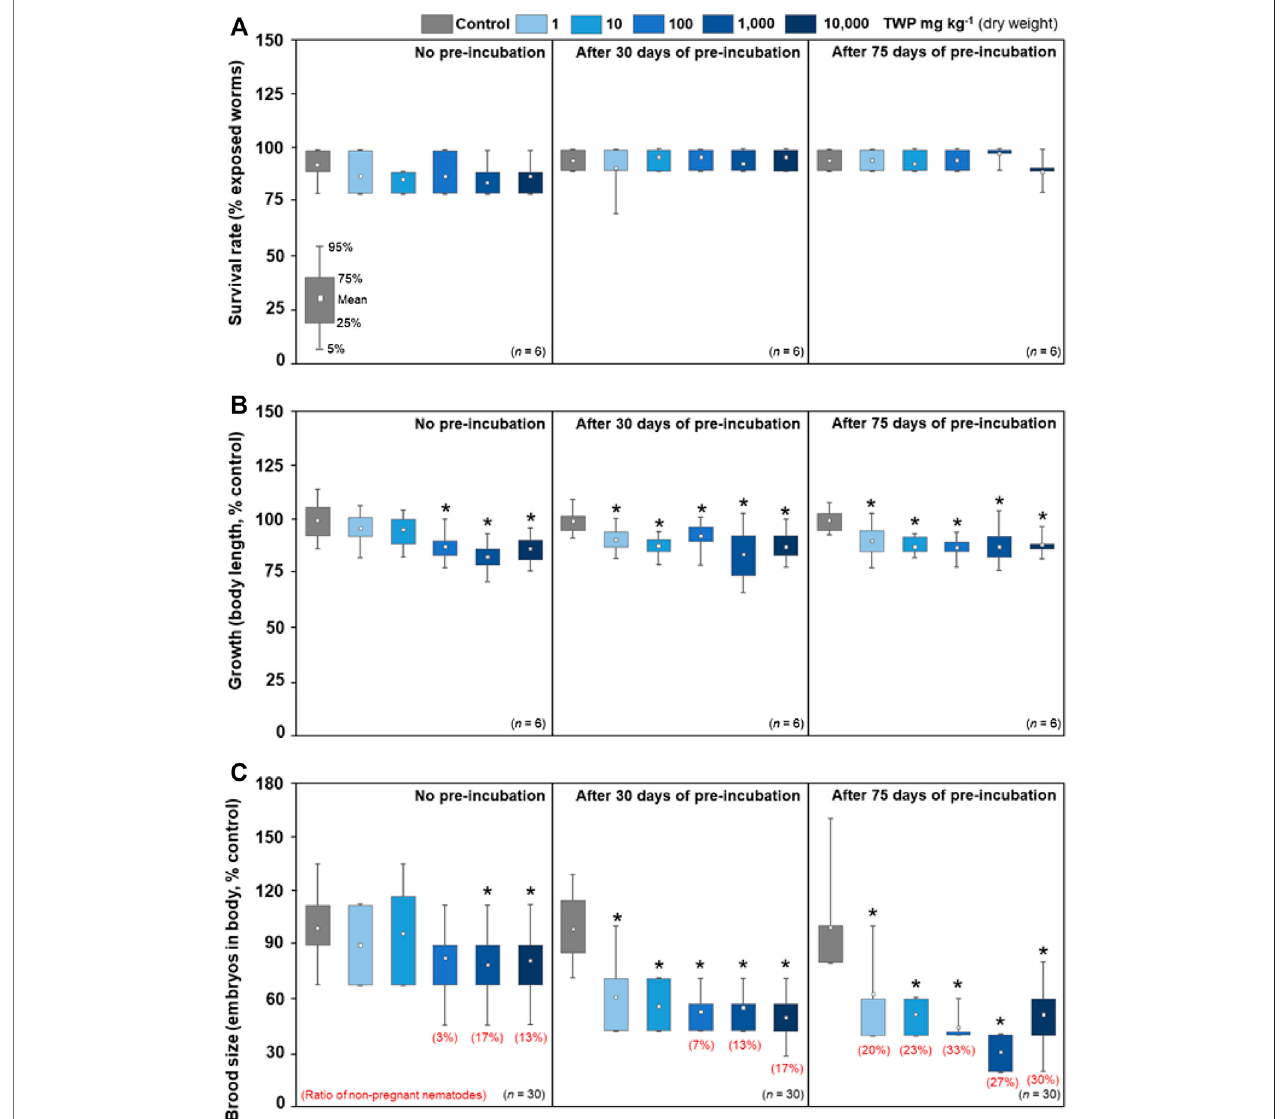
FIGURE 2 | Toxic effects of TWPs on (A) survival, (B) growth (body of length), and (C) brood size (number of embryos in body) of C. elegans after short-term exposure period (2 days). The short-term exposure tests were performed after three different soil pre-incubation times (no pre-incubation, 30 days, and 75 days). The survivalrate(%)wascalculatedtoinitiallyexposednematodes,andthedataofgrowthandbroodsizewerenormalizedtoeachcontrolgroup(%control).Theasterisks(*) indicate signi fi cant ( p < 0.05) differences compared to the control treatment group.